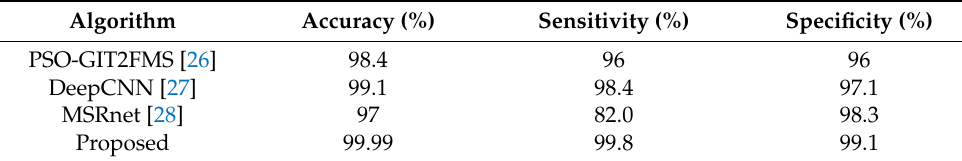
Table 4. Performance measure